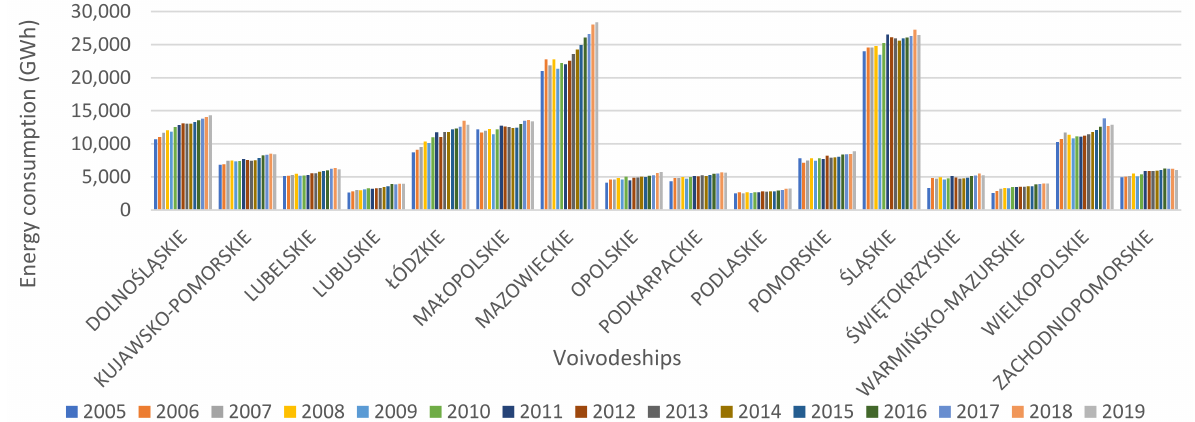
Figure A5. Energy consumption in individual Polish voivodeships in 2005–2019 (GWh). Source: Own calculations based on the LDB.